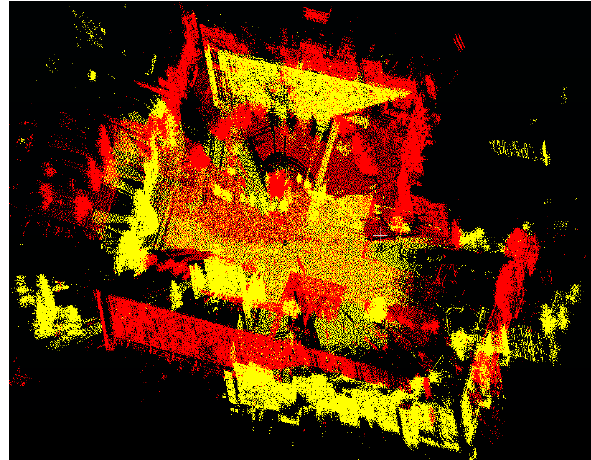
Figure 7. Two point clouds of Yamnuska hall before registration